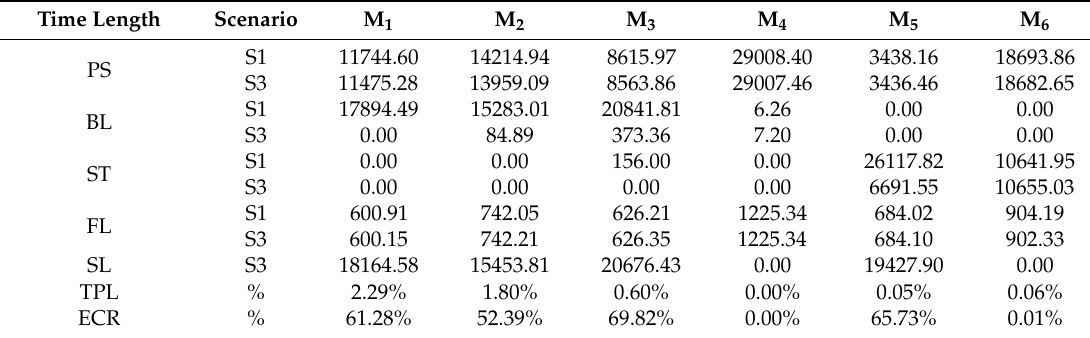
Table 6. Time length of machine states and machine performances comparison in S1 and